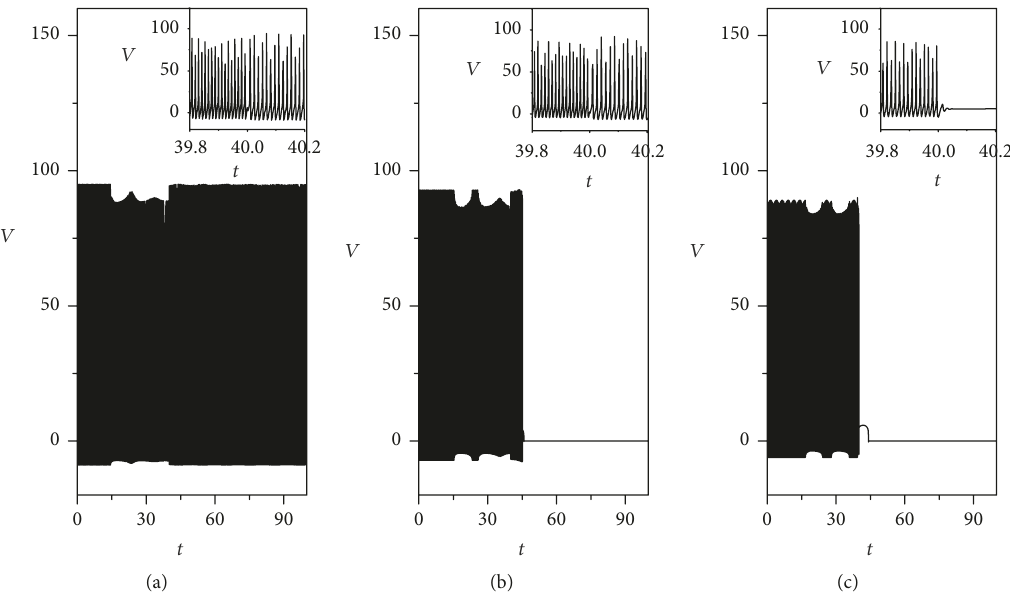
Figure 7: Sampled time series for membrane potential of neuron coupled by astrocypte when autapse driving is considered at 𝜏 = 2 , for = 0.8 , and inserted figures are enlarged ones. And the external (a) 𝑔 𝑒 = 0.1 , (b) 𝑔 𝑒 = 0.5 , and (c) 𝑔 𝑒 = 1.0 . The parameter is set as 𝑟 IP 3 forcing current regulates the neuron by 𝐼 ext = 10.0 𝜇 mol/L ⋅ cm 2 at 𝑡 < 40 s. The inserted figure is enlarged to show the sampled time series for membrane potential from 𝑡 = 39.8 to 40.2